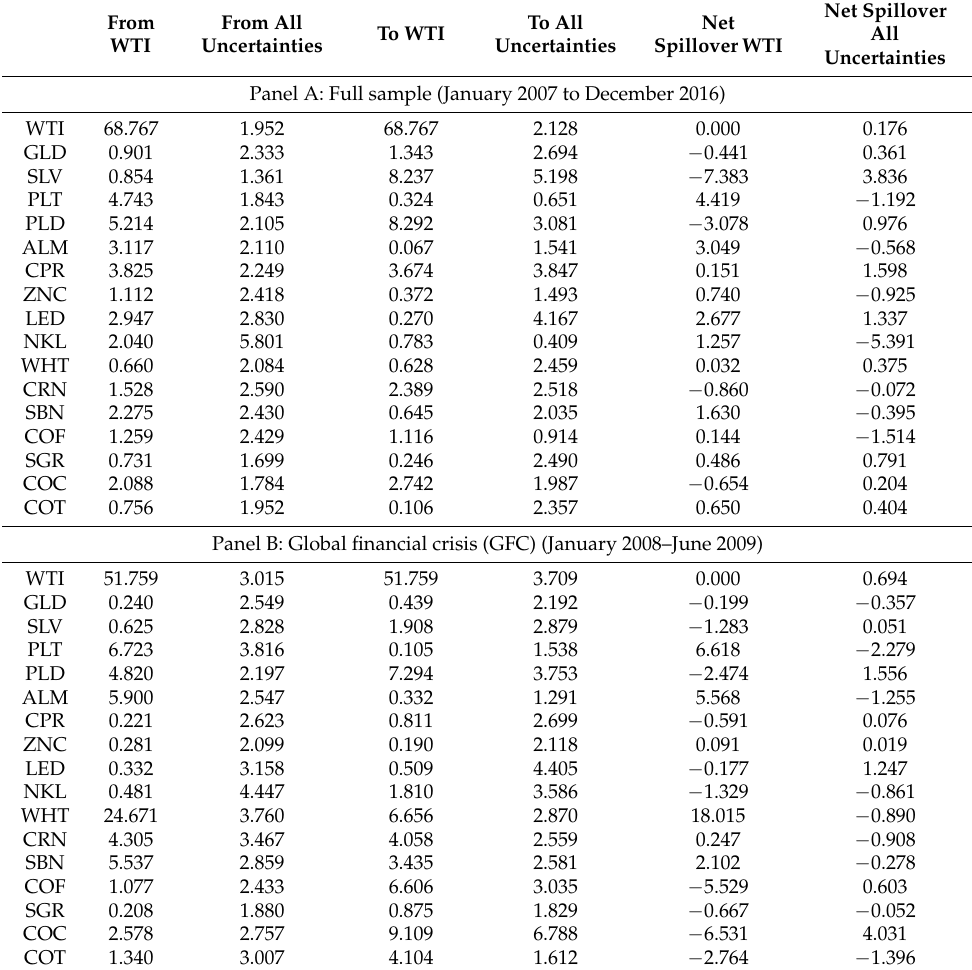
Table 2. Diebold–Yilmaz (DY) spillover